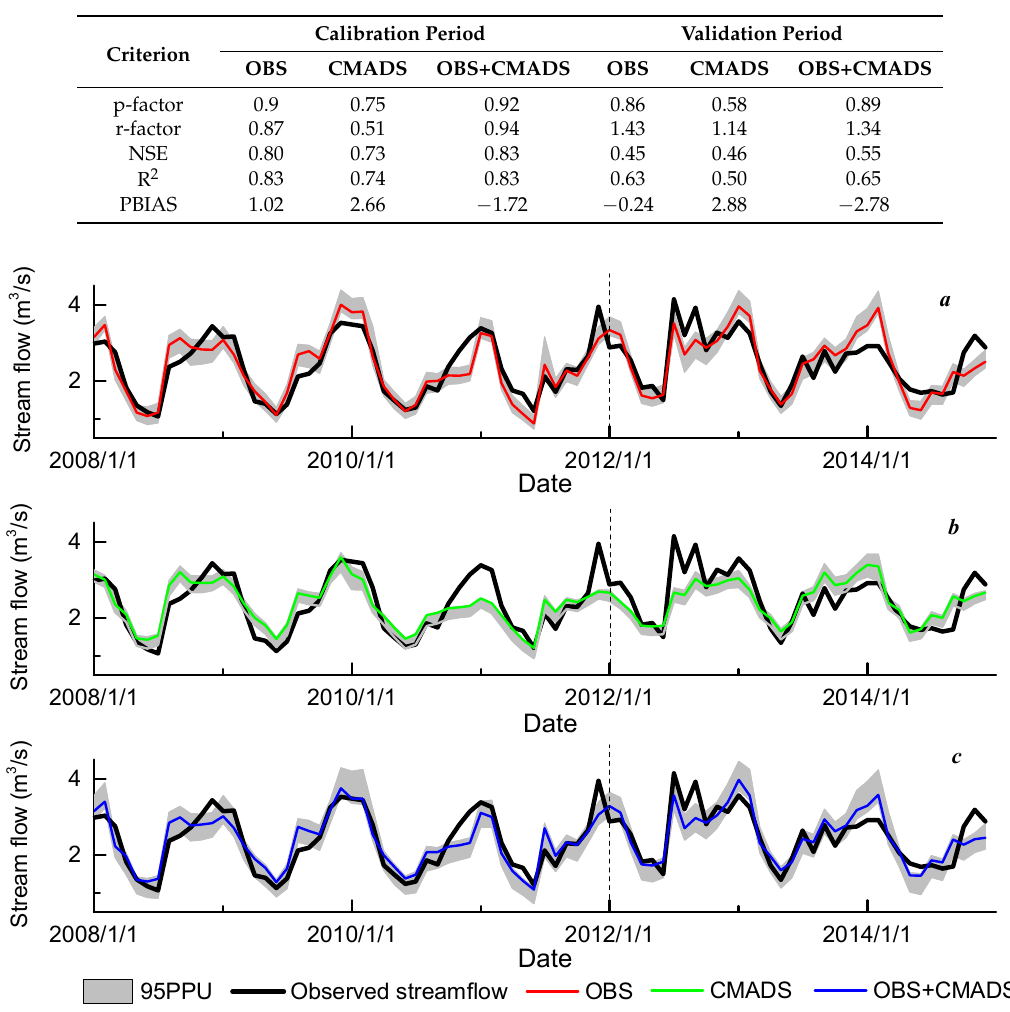
Figure 13. Simulation results of SWAT with ( a ) OBS; ( b ) CMADS; ( c ) OBS+CMADS in the Hailiutu River basin during the period 2008–2014.